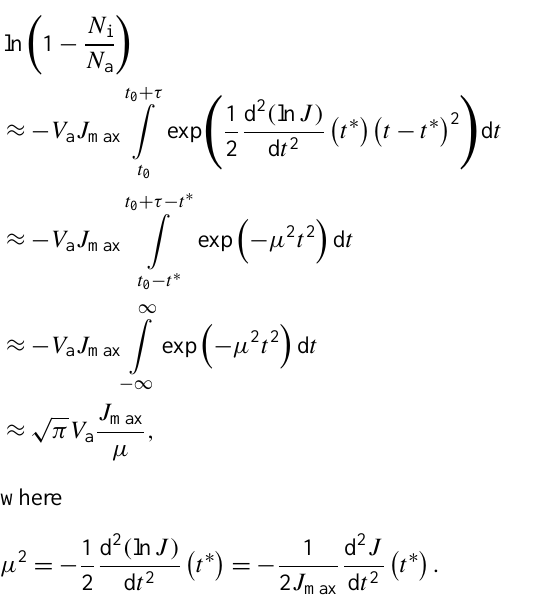
Figure 9. Same as Fig. 7 ( T 0 = 195K) but for α = 0 . 001 (filled circles) and α = 1 (empty